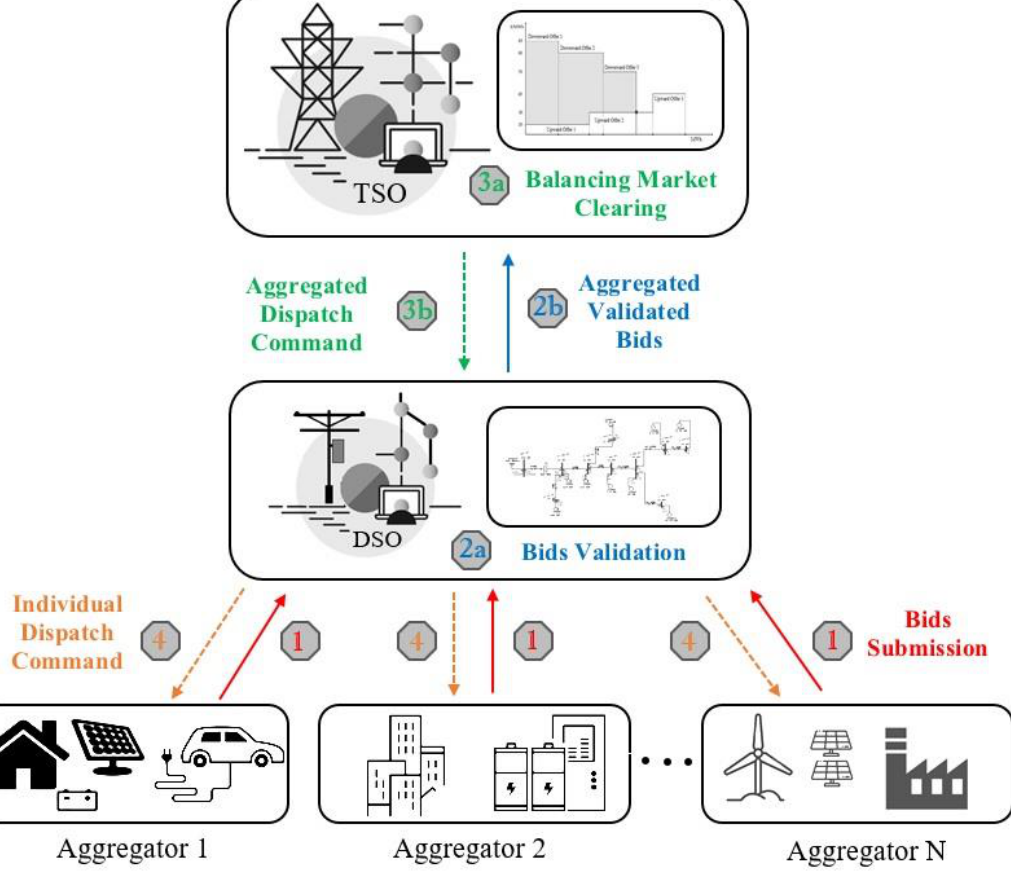
Figure 1. Aggregators’ DSO-managed participation in balancing market (BM) framework.